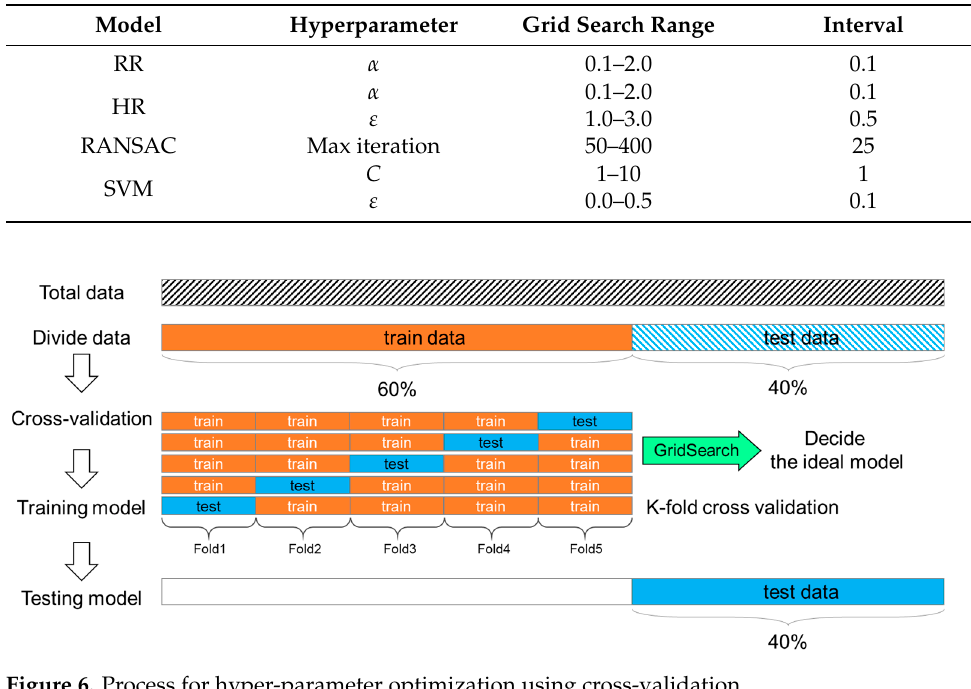
Figure 6. Process for hyper-parameter optimization using cross-validation.